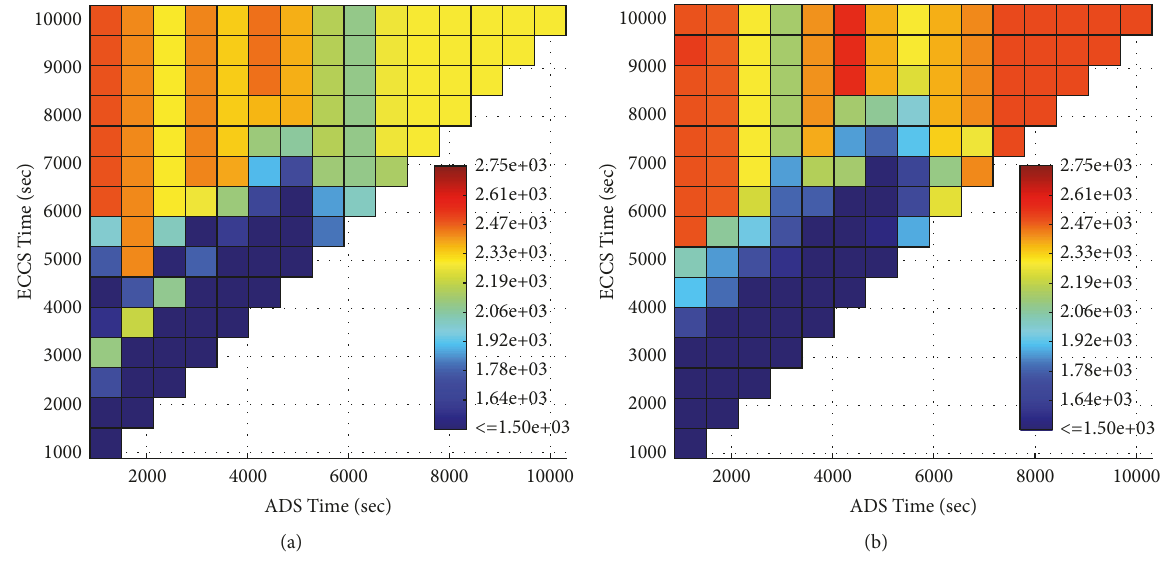
Figure 9: Mass averaged temperature (K) of particulate debris above the core support plate at 𝑇 𝑟𝑒𝑓 predicted by (a) MELCOR 1.86 and (b) MELCOR